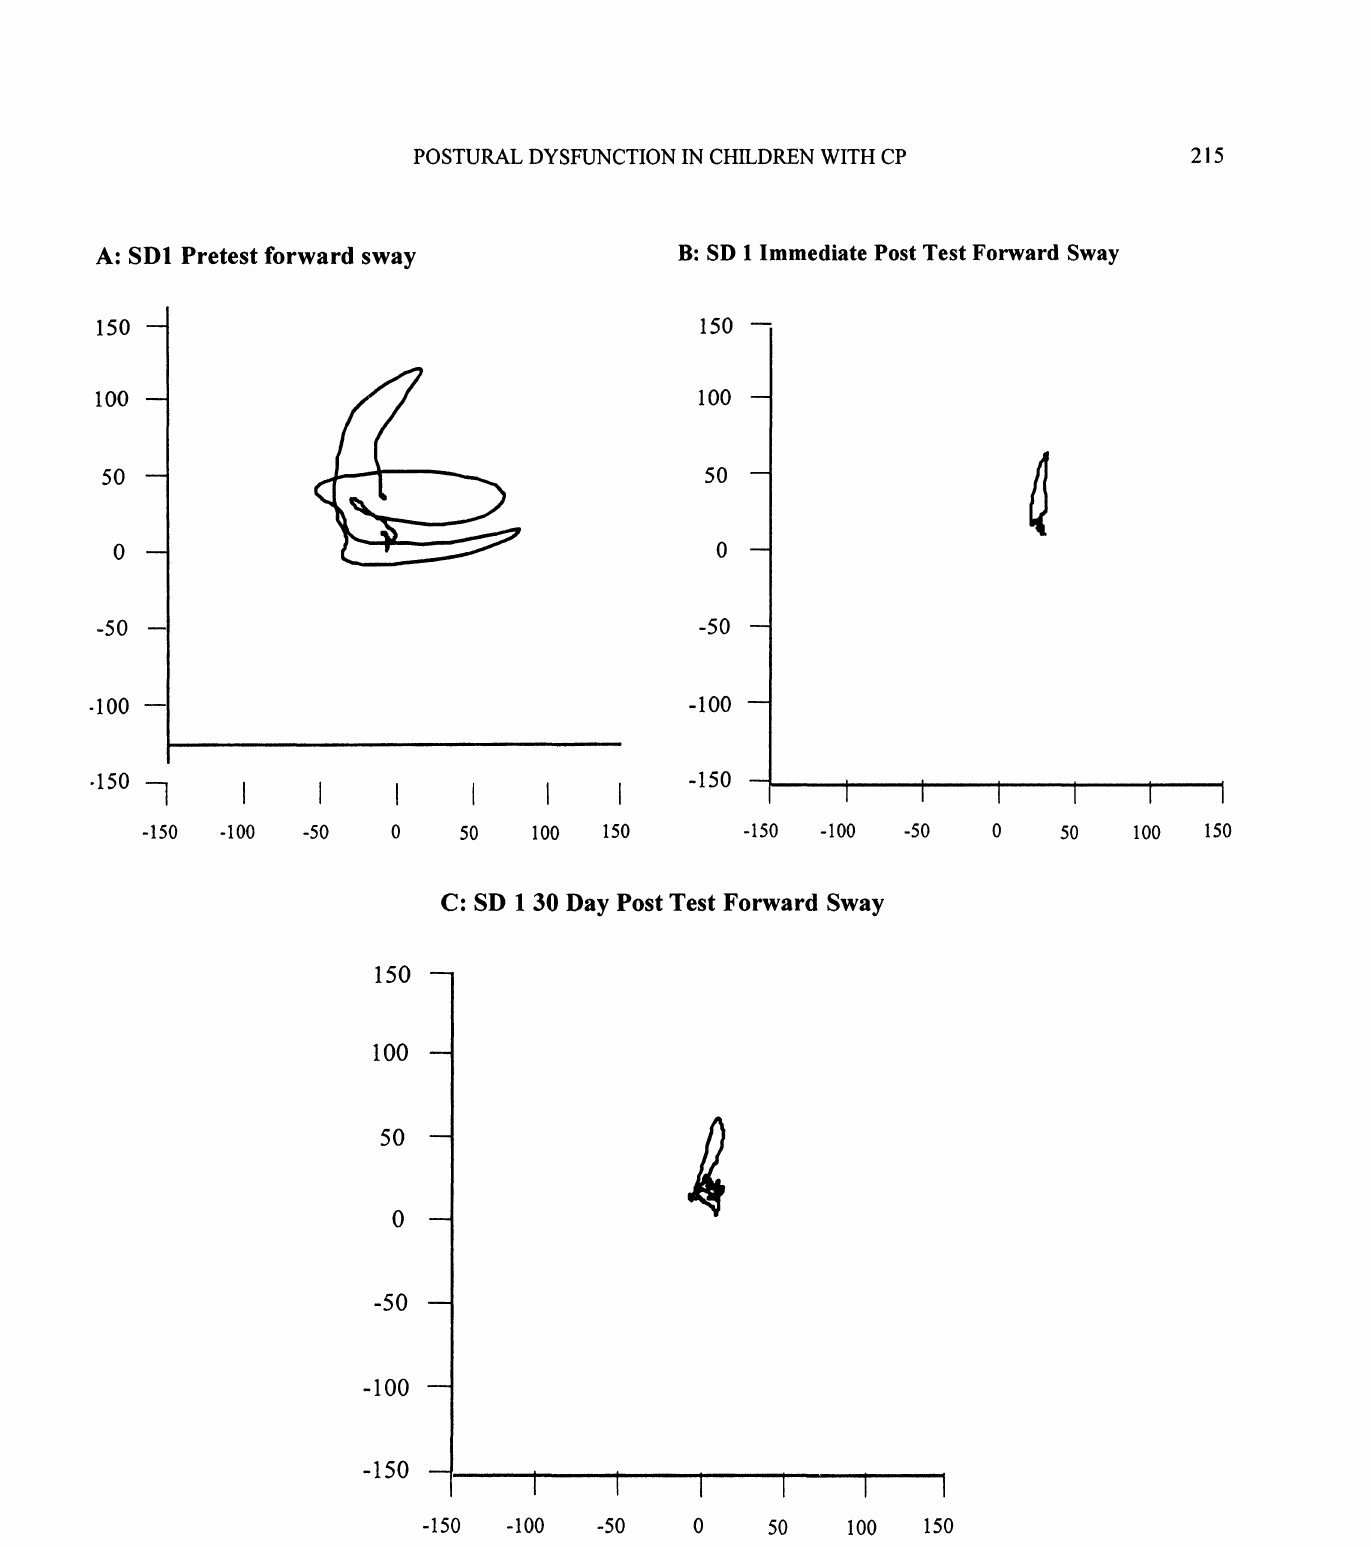
Fig. 2: Graph showing total COP movement from one pretraining (a), post-training (b), and one month post-training tests (c), in a child with spastic diplegia (SD1 child with spastic diplegia #1. age 12 yrs, 11 m) (from Shumway-Cook et al.,